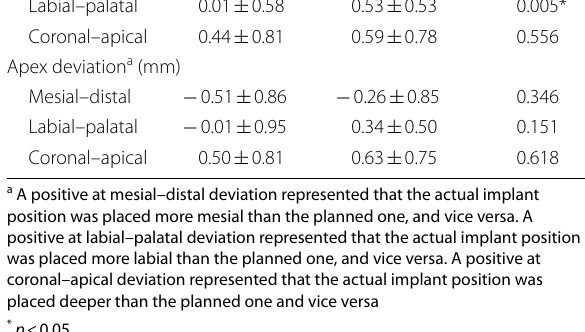
Table 1 Demographics and surgical data of involved patients Group